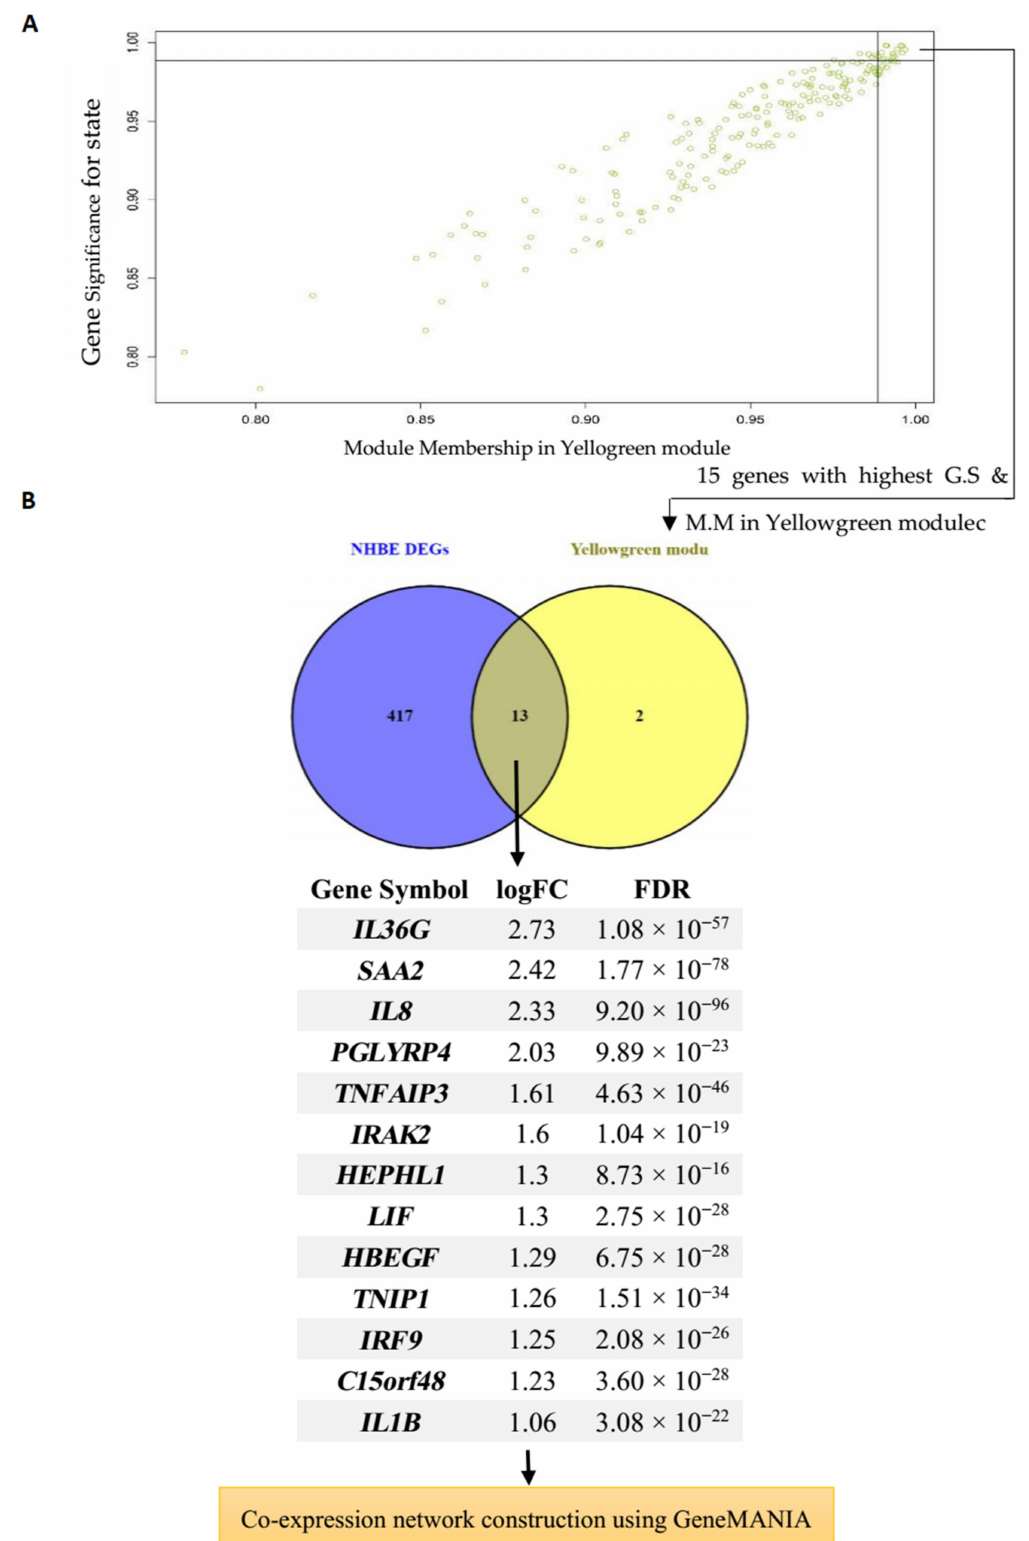
Figure 5. Hub gene detection for NHBE dataset. ( A ) Yellow-green module features of G.S and M.M significantly correlated with the SARS-CoV-2 trait (mock-infected and SARS-CoV-2-infected). Each point represents an individual gene within each module, which is plotted by G.S on the y-axis and M.M on the x-axis; ( B ) Evaluation of similarities between DEG and hub gene lists using a Venn diagram. Thirteen genes that were similar in both lists were then imported to GeneMANIA to construct a co-expression